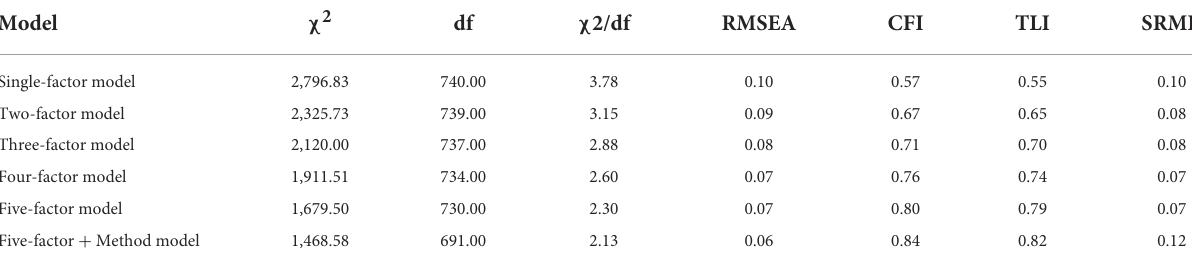
TABLE 3 The tests of divergent validity and common method bias to